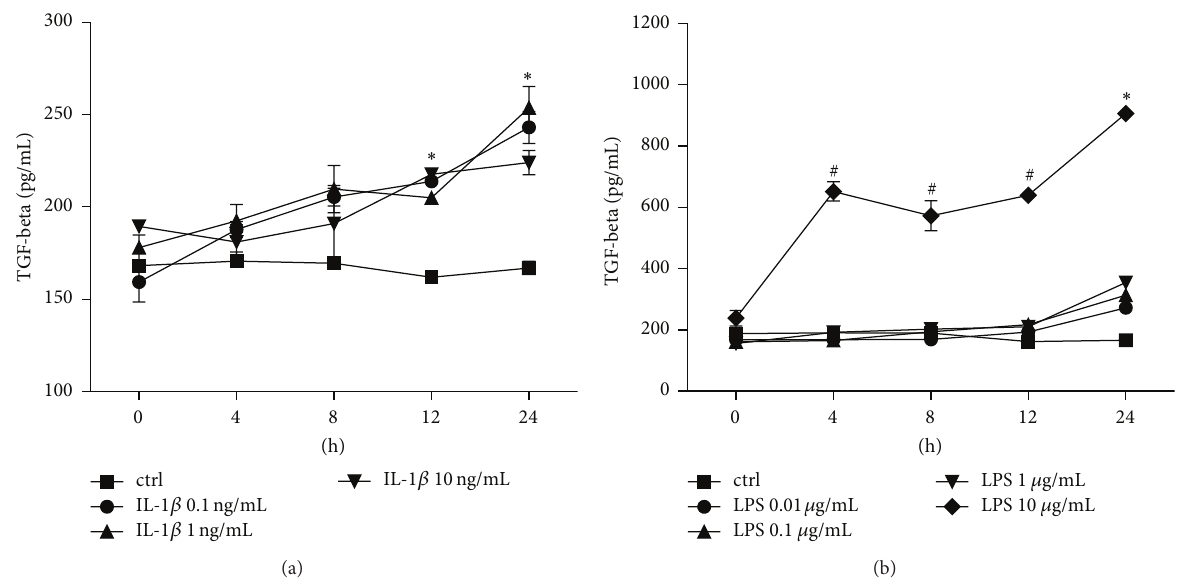
Figure 2: Transforming growth factor- (TGF-) beta release from lung epithelial cells A549 after IL-1beta (a) or lipopolysaccharide (LPS (b)) stimulation. Cells were stimulated with IL-1beta or LPS in indicated concentrations for different intervals (incubation time indicated below the 𝑥 -axis). After the incubation periods, supernatants were analyzed for TGF-beta concentrations. The data are presented as means ± s.e.m. ∗ 𝑃 < 0.05 , all groups versus corresponding control (ctrl); # 𝑃 < 0.05 , LPS 10 𝜇 g/mL versus corresponding